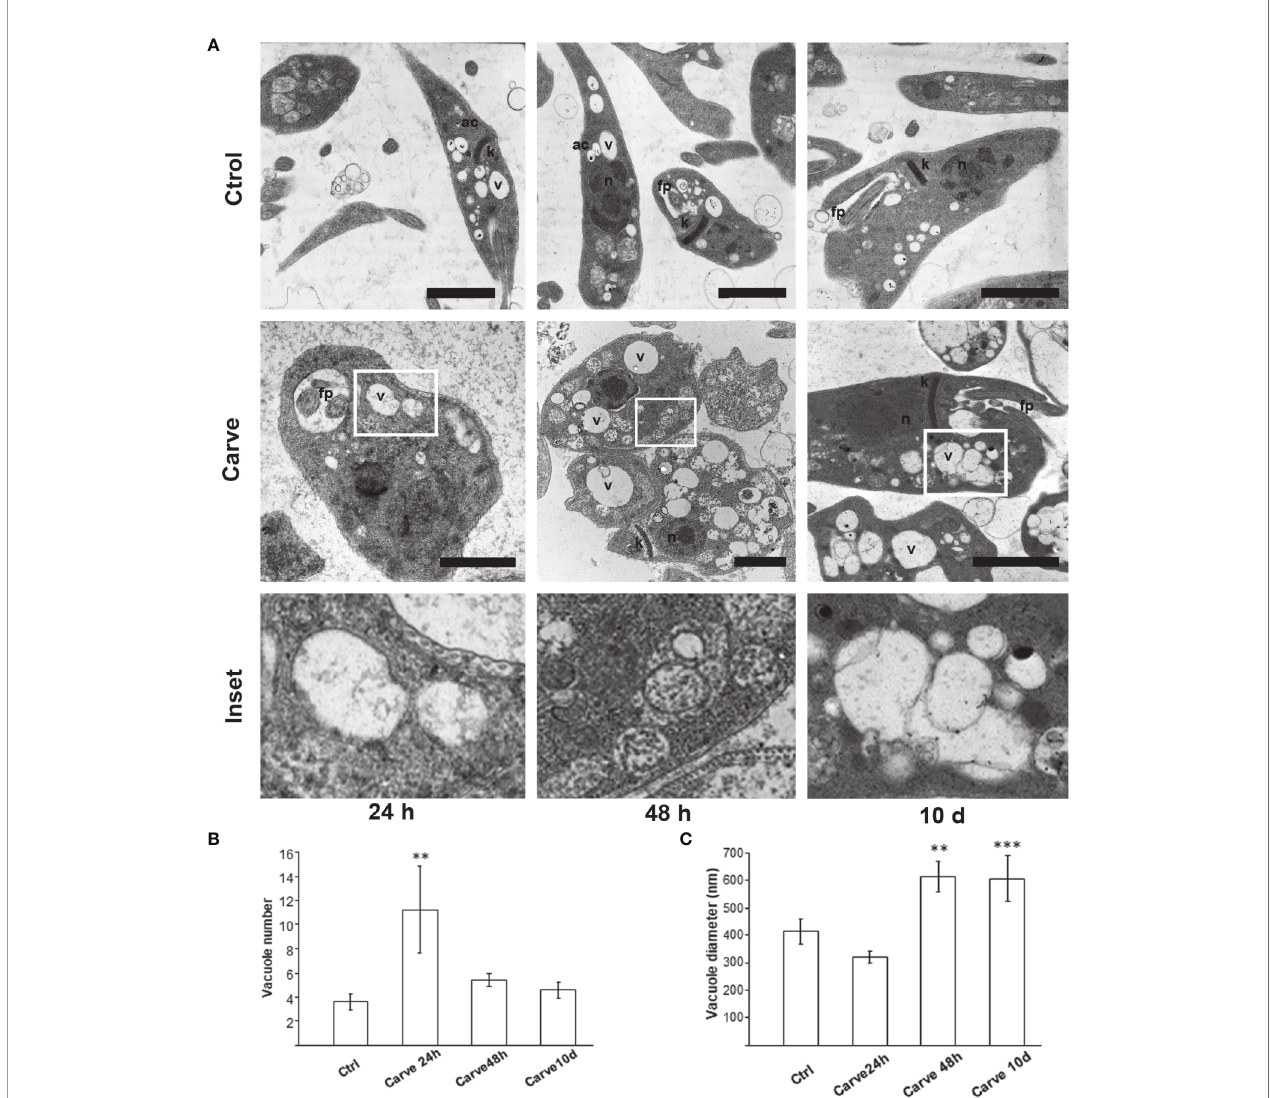
FIGURE 2 | Phenotypic alterations suffered by T. cruzi epimastigotes under carvedilol treatment. (A) TEM images of control parasites (Ctr) showing the typical elongated body, with terminal fl agellum (f) emerging from the fl agellar pocket (fp) and normal morphology of reservosomes (r), acidocalcisomes (ac), nucleus (n) and kinetoplast (k); carvedilol treated parasites (Carve) displayed abnormal vacuolization (v) and accumulation of multivesicular structures at 24 and 48 h and after 10 days of treatment. Bars: 2 m m. Insets Insets show the magni fi cations (5x) delimited in the original photo. Number (B) and diameter (C) of vacuoles quanti fi ed from the TEM images obtained from epimastigotes incubated with DMSO (Ctr) or 10 m M carvedilol (Carve) at the indicated times. Data are shown as mean +/- standard error of 3 independent experiments. **p < 0.01, ***p < 0.001 (Tukey test). A total of 50 cells per group was